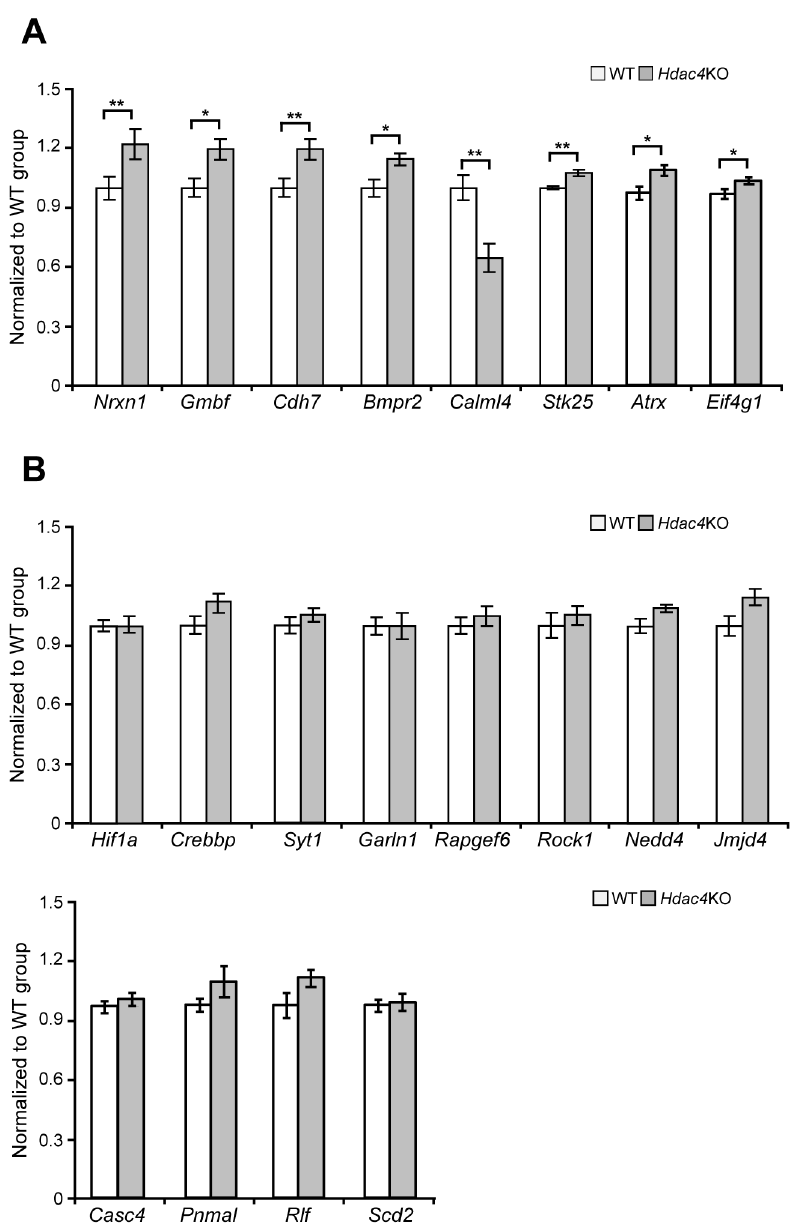
Figure 3. Validation of the genes predicted to be downregulated in Hdac4 knock-out P3 brains. (A) Nrxn1 (neurexin1), Gmbf (glia maturation factor beta), Cdh7 (cadherin 7), Bmpr2 (bone morphogenic protein receptor, type II), Stk25 (serine/threonine kinase 25), Atrx (alpha thalassemia/mental retardation syndrome X-linked homolog) and Eif4g1 (eukaryotic translation initiation factor 4, gamma 1) were modestly upregulated in Hdac4 KO P3 brains. Calml4 (calmodulin-like 4) was the only gene that was downregulated (B) The expression level of Hif1α (hypoxia inducible factor 1 alpha subunit), Crebbp (CREB-binding protein), Syt1 (synaptotagemin 1) Garln1 (GTPase activating RANGAP domain like 1 protein), Rapgef6 (Rap guanine nucleotide exchange factor GEF6), Rock1 (Rho-associated coiled-coil containing protein kinase 1), Nedd4 (NEDD4 binding protein), Jmjd4 (jumonji containing protein 4), Casc4 (cancer susceptibility candidate 4), Pnmal (PNMA-like 2), Rlf (rearranged L-myc fusion sequence) and Scd2 (stearoyl- Coenzyme A desaturase 2) did not change between Hdac4 KO and WT P3 brains. All mRNA expression levels were assessed by Taqman qPCR and presented as a relative expression ratio to the geometric mean of three housekeeping genes Atp5b , Canx , Rpl13α . Error bars are S.E.M (n>7). * p <0.05, ** p <0.01.